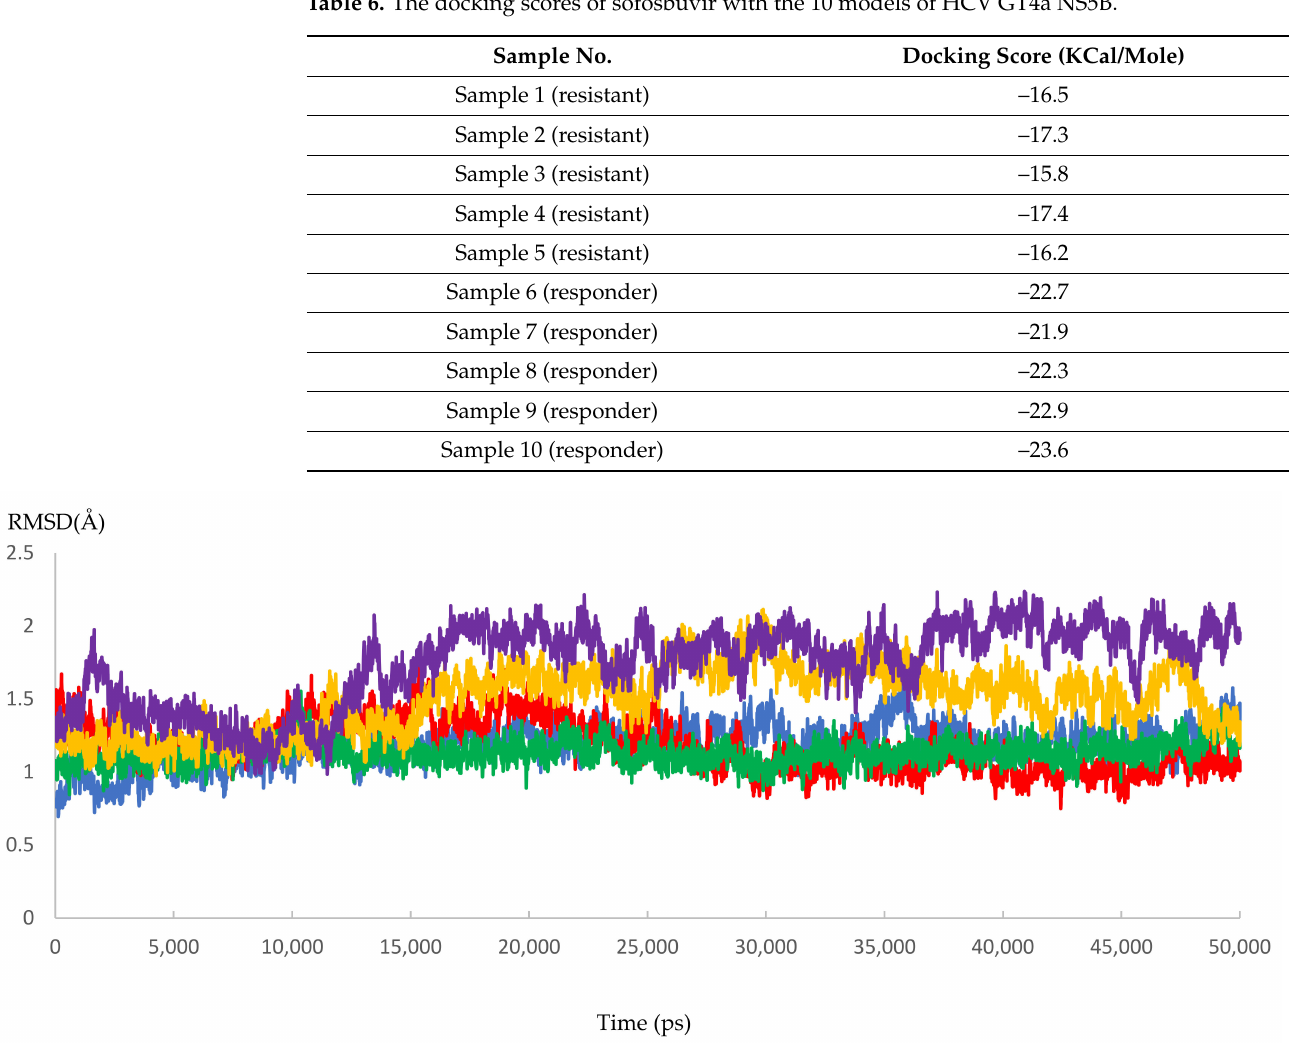
Table 6. The docking scores of sofosbuvir with the 10 models of HCV GT4a NS5B.